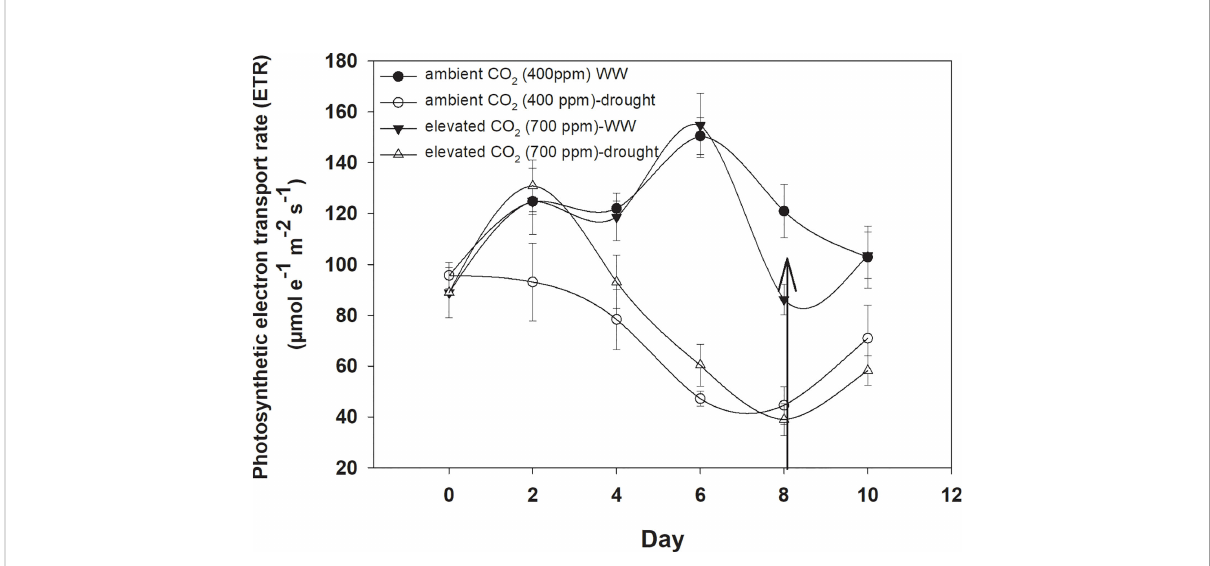
FIGURE 5 Effect of CO 2 concentrations and moisture conditions on the photosynthetic electron transport rate of Datura stramonium . The vertical line on the data point represents the standard error of the mean and the vertical arrow line after Day 8 represents the addition of water in the drought treatments. WW,